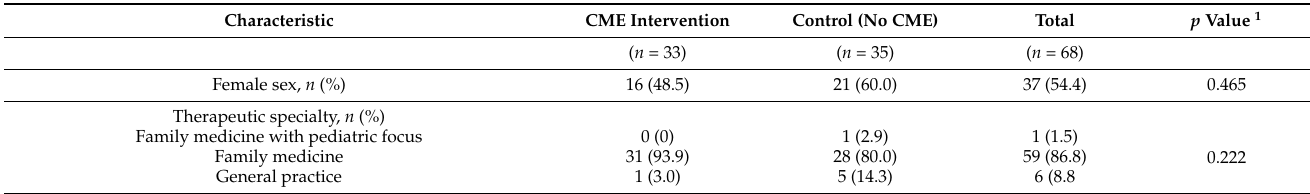
Table 1. Mixed model-binary logistic regression for the odds of immunization following a physician– parent